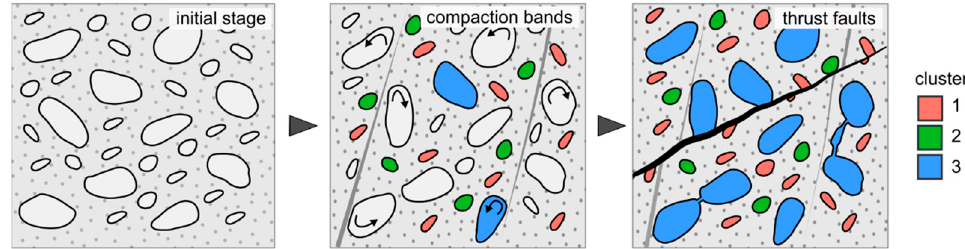
Figure 13. The evolution of the Krosno Beds from the Nasiczne site decoded from the studied sample.